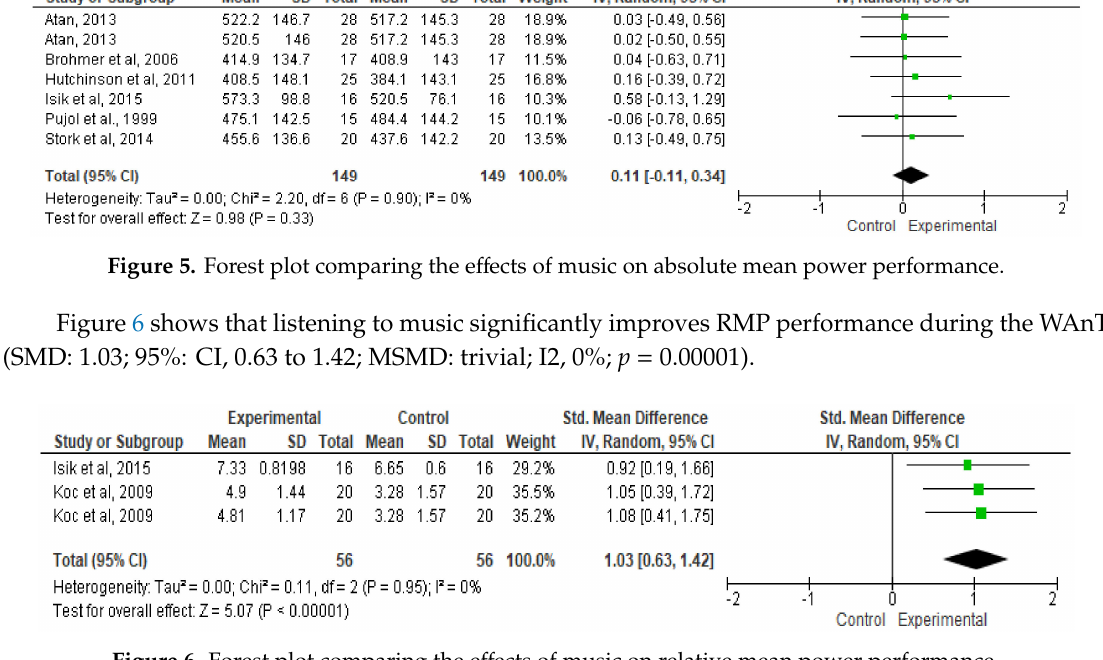
Figure 6. Forest plot comparing the e ff ects of music on relative mean power performance.